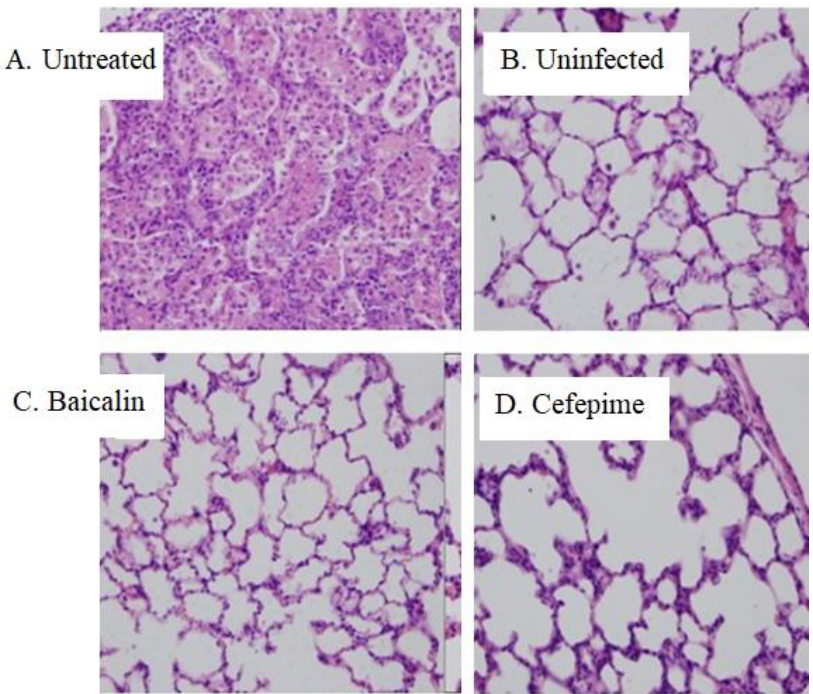
Figure 6. Microscopic changes of the lung tissues of the different animal groups (H&E staining,